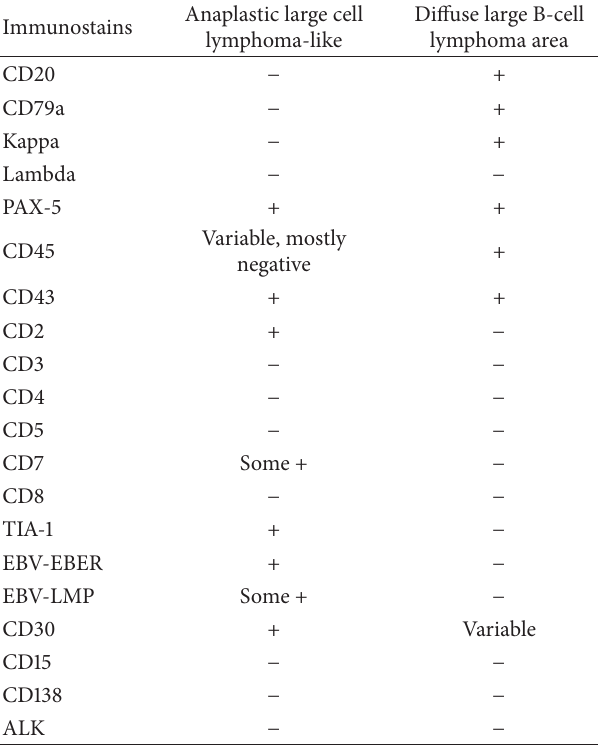
Table 1: The comparison of immunophenotype between the anaplastic large cell lymphoma-like area and conventional diffuse large B-cell lymphoma